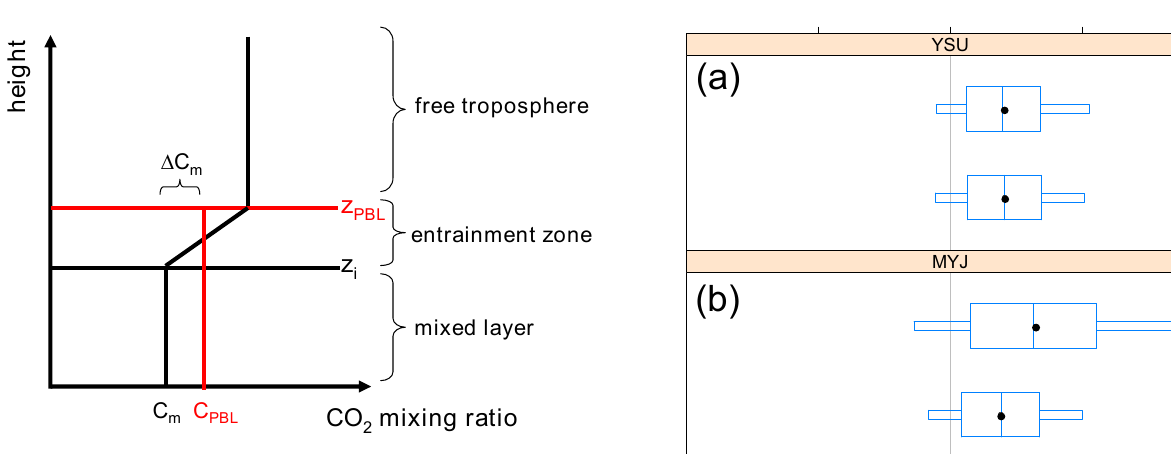
Fig. 5. Illustration of the effect of differences between the mixing height ( z i ) and a diagnosed PBL top ( z PBL ) on the ML mean mole fraction ( C m ). The column mixing ratio integrated from the surface to z PBL has a higher value than a similar column integrated to the top of the well mixed part ( z i ). The difference between these two mean mixing ratios is shown as 1C m .